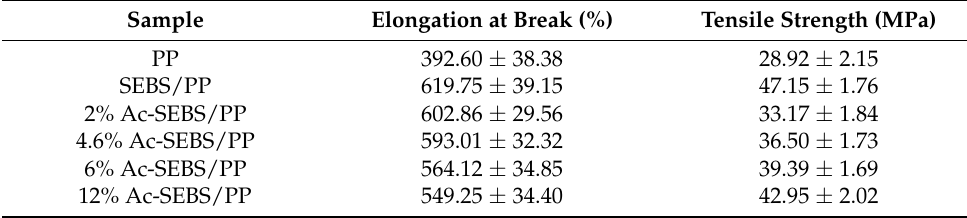
Figure 5. Stress-strain curve of PP and its composites. Table 1. Summary of tensile test data of the